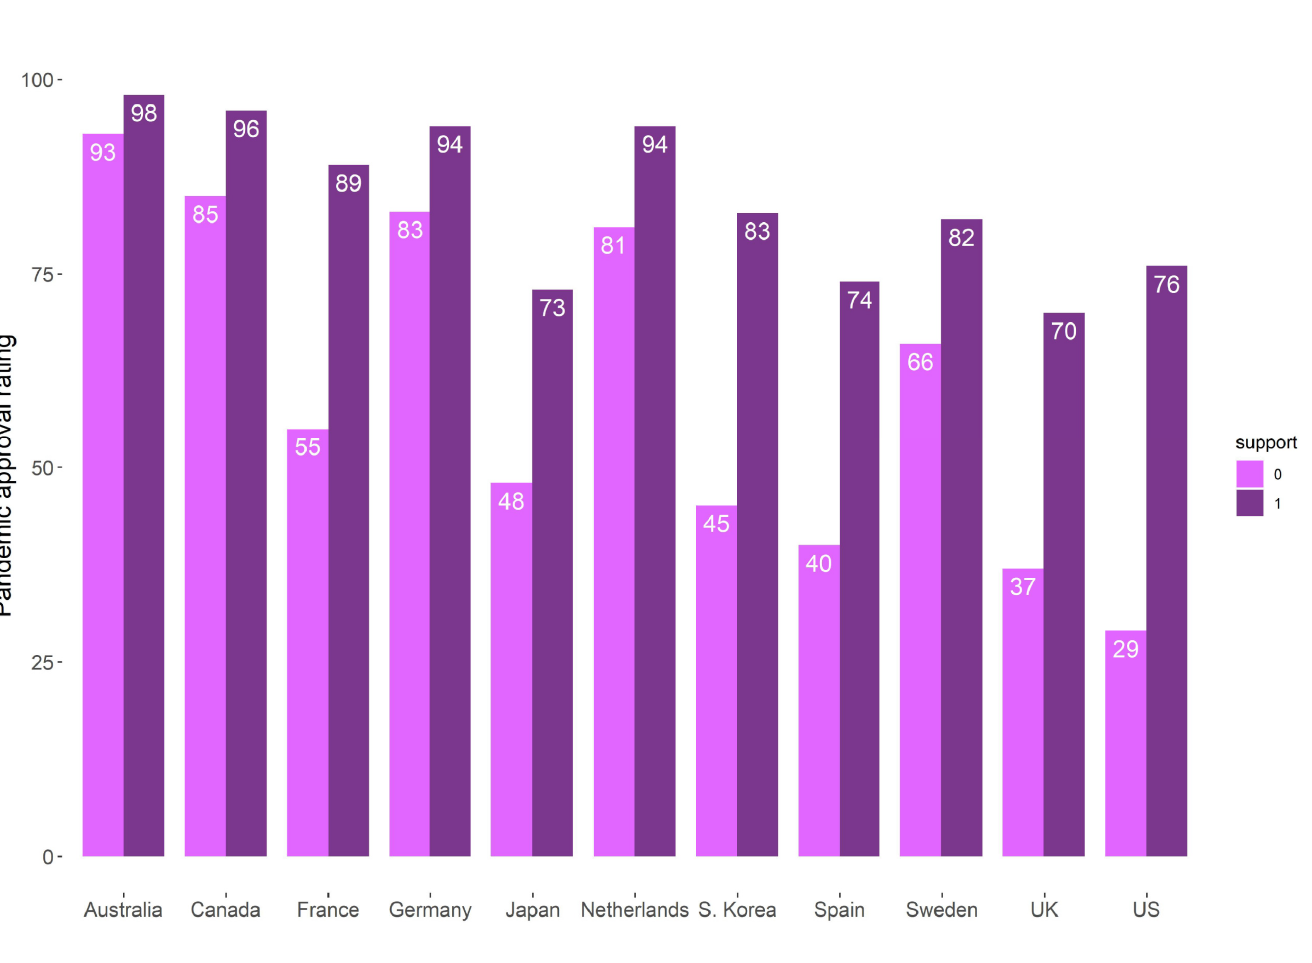
PLOS ONE | https://doi.org/10.1371/journal.pone.0260062 March 2,